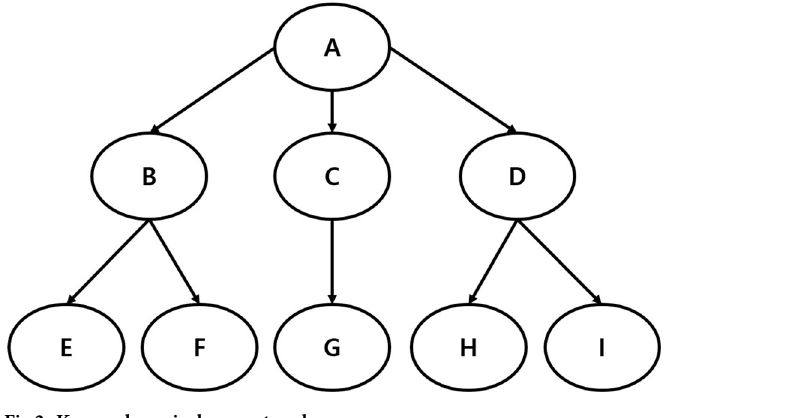
Fig 2. Keywords equivalence network.